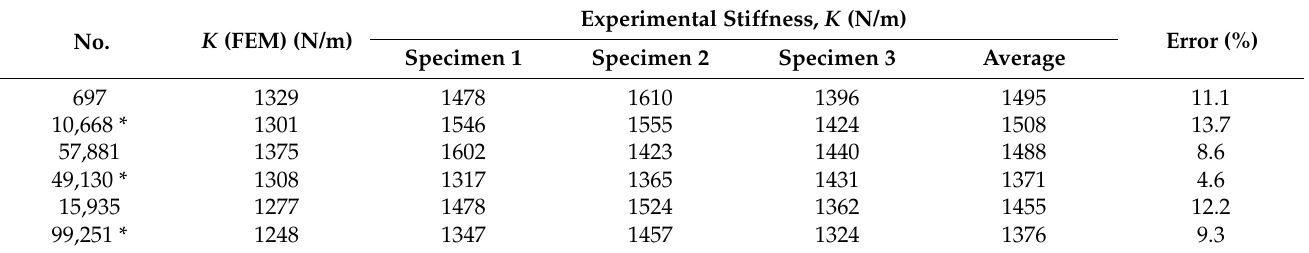
Table 2. Comparison of simulated and experimental stiffness K (* soft material ahead of the crack tip).